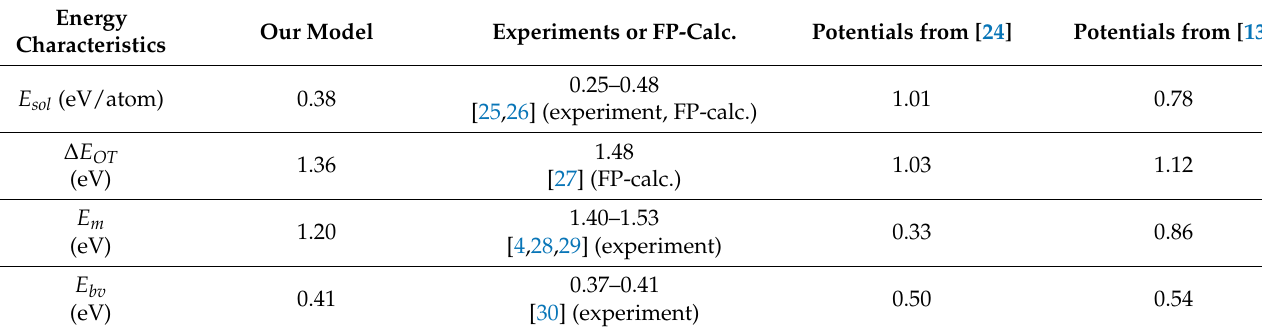
Table 1. Energy characteristics of carbon impurity in f.c.c.